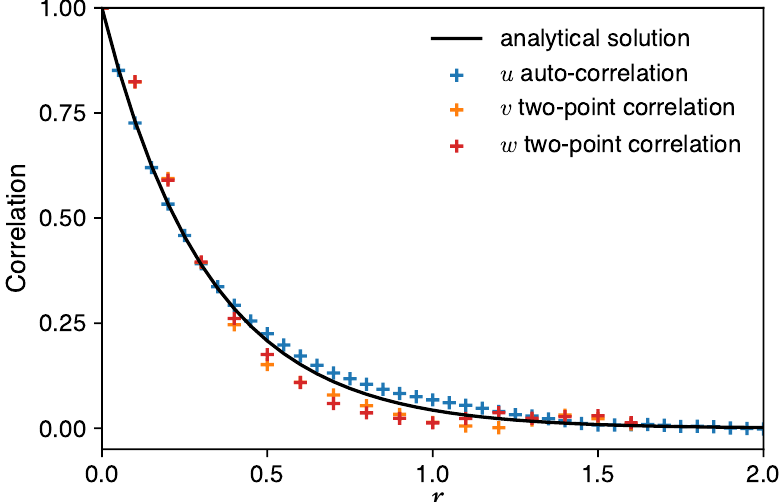
Figure 4. Two-point correlations for two velocity components v and w on the central horizontal line, and auto-correlation for velocity component u . The black line denotes the analytical exponential correlation for the same integral length scale and the equivalent integral time